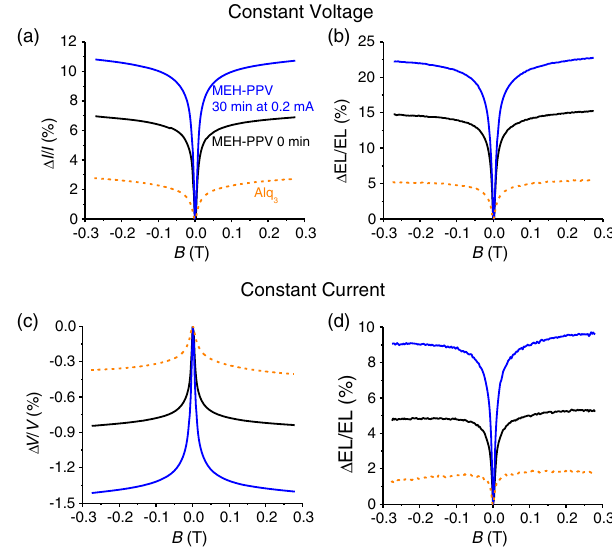
FIG. 11. Magnetotransport and magnetoluminescence in MEH-PPV and Alq 3 devices. Magnetotransport and magneto- luminescence at (a),(b) constant voltage and (c),(d) constant current before and after device conditioning in MEH-PPV and Alq 3